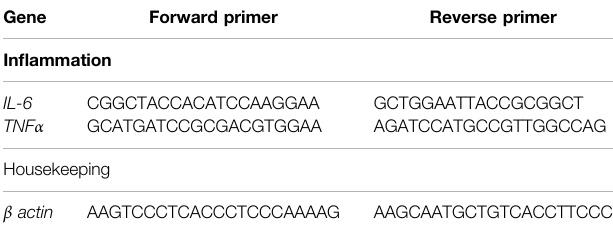
TABLE 1 | Forward and reverse primers sequence used in